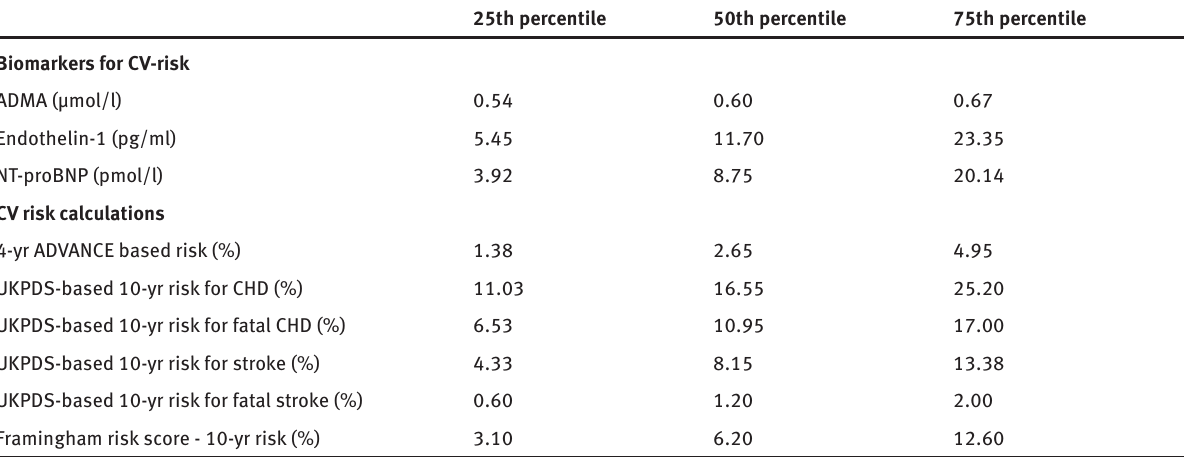
Table 1: The biochemical markers of cardio-vascular risk / endothelial dysfunction and the calculated cardio-vascular risks are presented as medians and interquartile ranges (skewness and curtosis were both